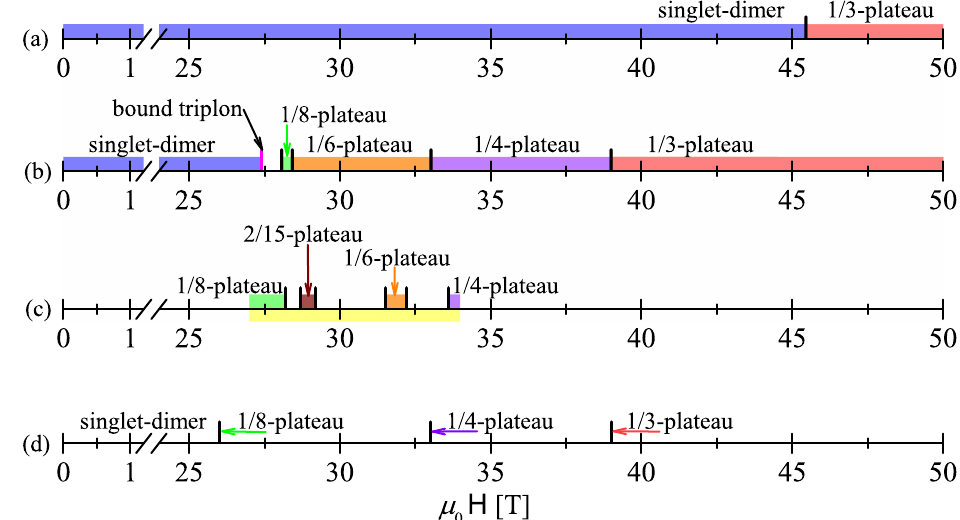
Figure 1: A schematic phase diagram for the Shastry-Sutherland model (panels a, b) and for the related magnetic compound SrCu strips indicate different plateaux. (a) The Ising-Heisenberg model on the Shastry- Sutherland lattice with the intradimer J / k couplings, the thick vertical bar corresponds to µ